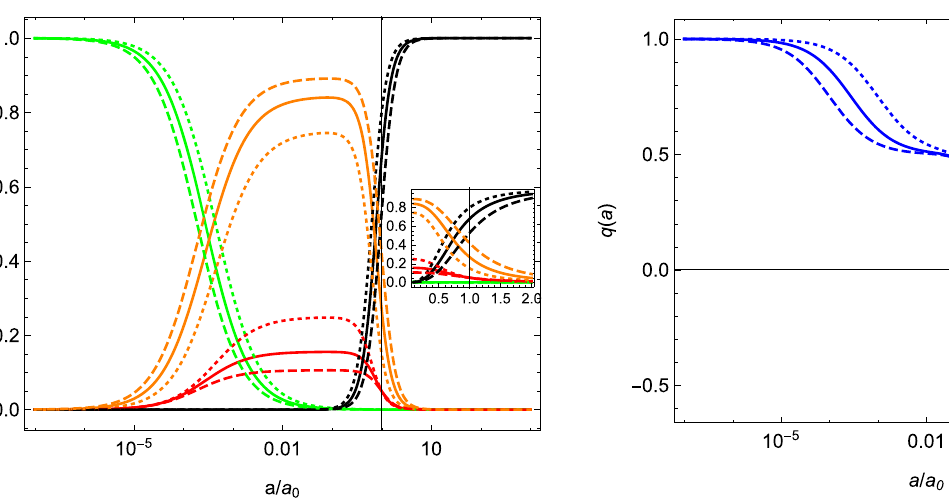
Fig. 2 The same as Fig. 1. The calculated cosmic evolutions of dimen- sionless density parameters as functions of a / a 0 . The calculations are carried out for the standard (cid:2) CDM model. The cosmic evolution, as well as the results regarding arbitrary initial perturbations, are shown in solid, dashed, and dotted curves. The zoomed-in plot illustrates the density parameters in the vicinity of a / a 0 = 1